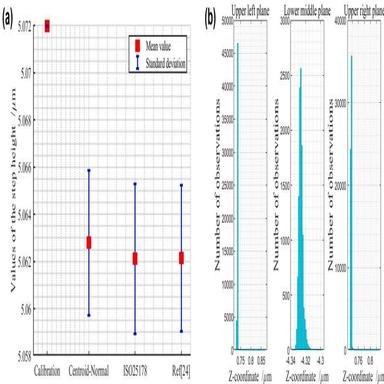
Comparison of results in Experiment 2: (a) Step heights computed by each method; (b) Distribution of the Z-coordinate values of the evaluation planes.